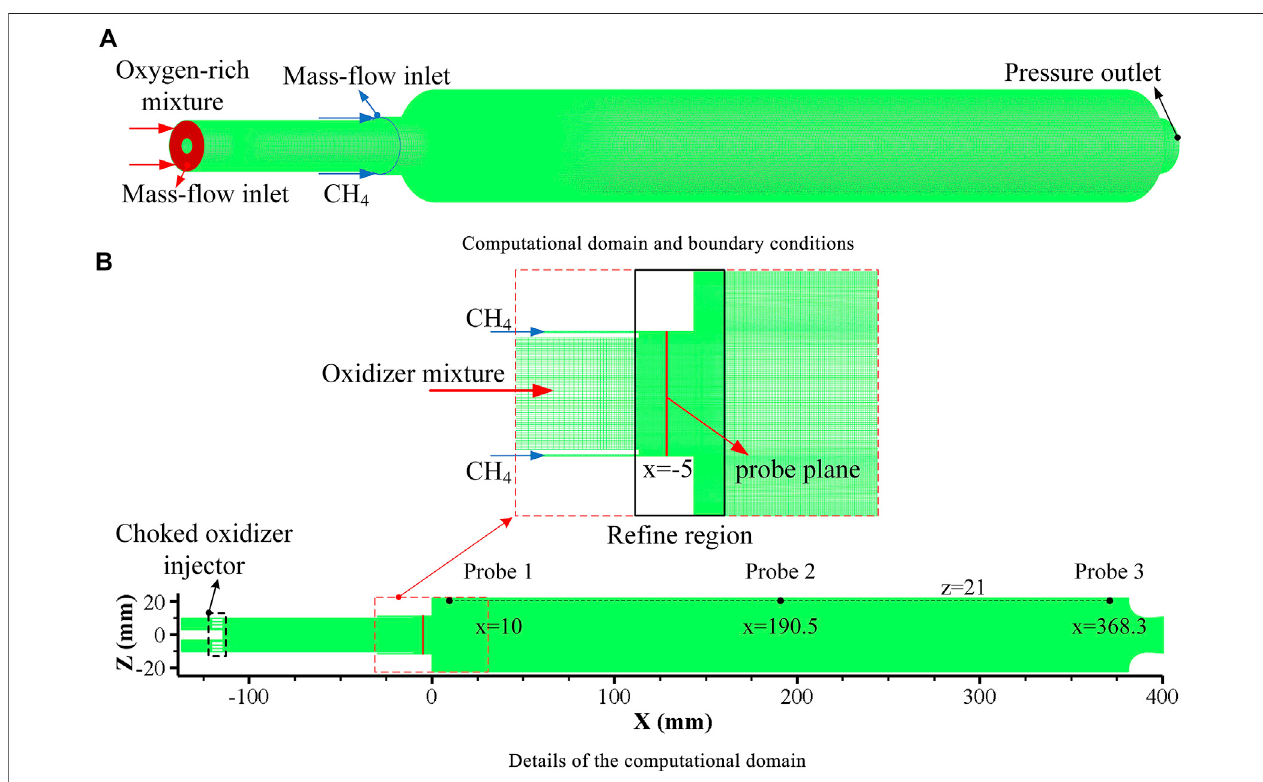
FIGURE 3 | Computational domain and boundary conditions. (A) Computational domain and boundary conditions, (B) Details of the computational domain.